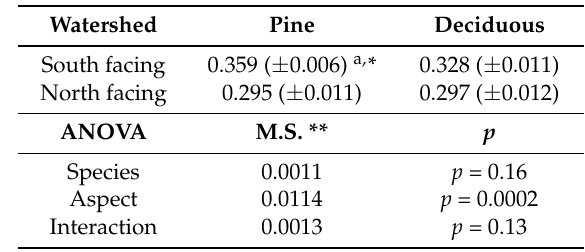
Table 2. Turnover rates (litterfall C mass/sum of C in mass of ages 1–13 years).